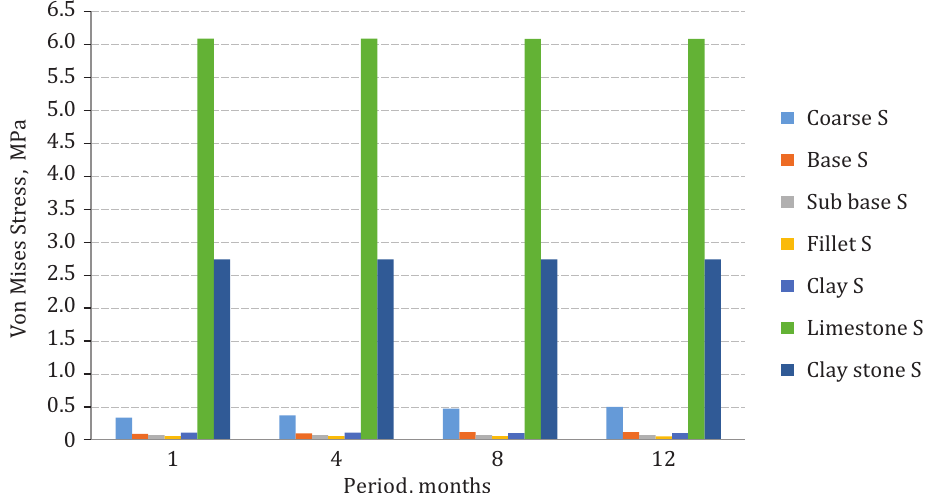
Figure 13. Von Mises stress-time changes of the layers for